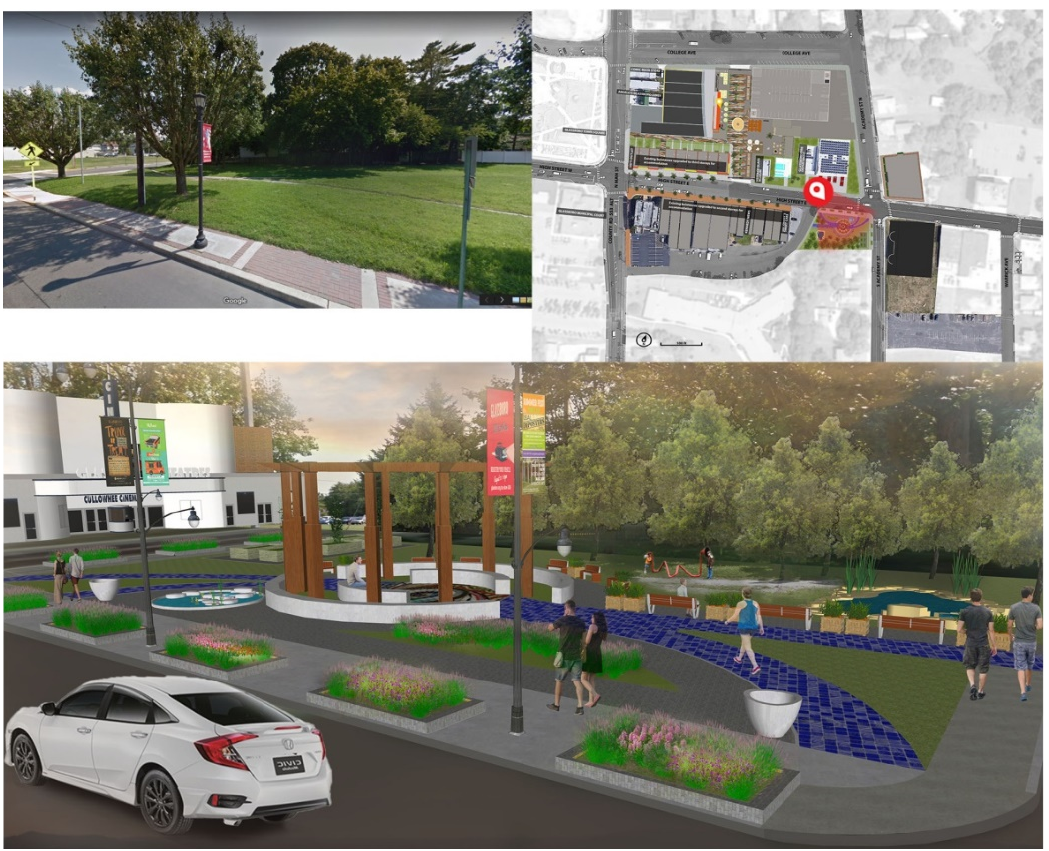
Figure 2. Existing and future conditions of a pocket park.